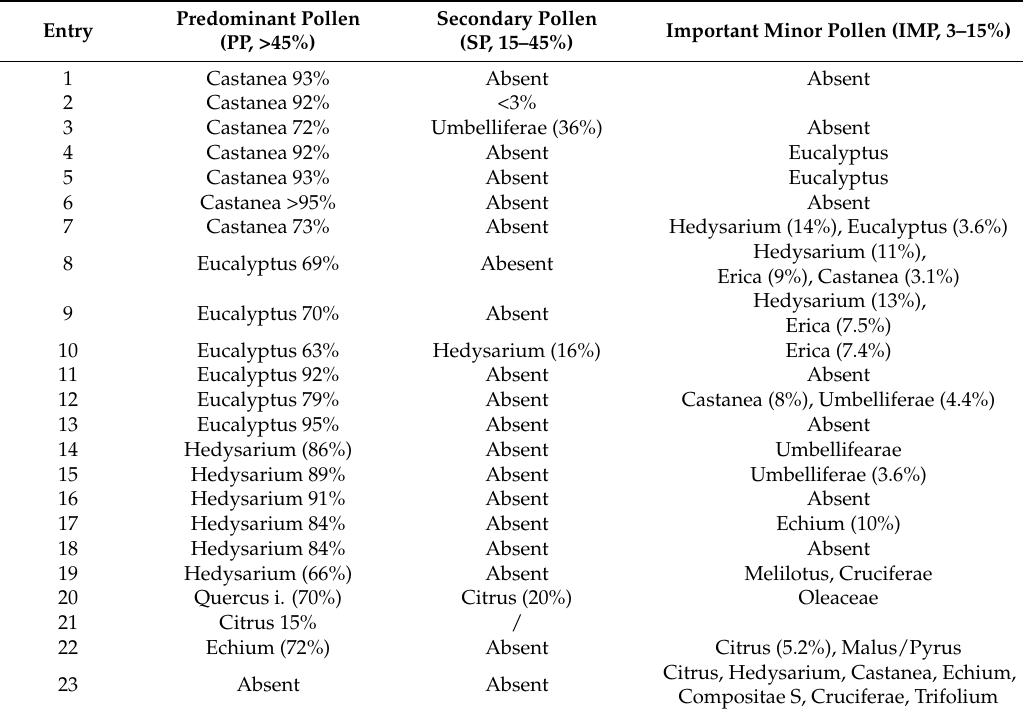
Table 2. Pollen analytical data for the investigated